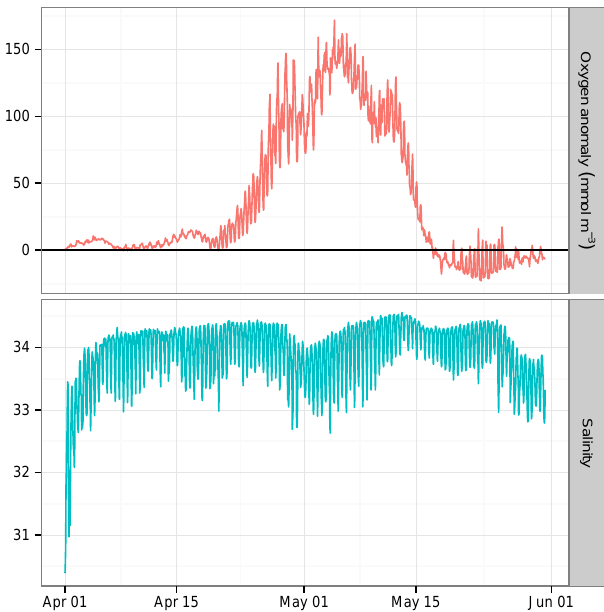
Figure 10. Raw (30min) Warp SmartBuoy time series showing significant variability in oxygen anomaly (red) and salinity (blue) within each tidal cycle. Here the oxygen anomaly neglects the su- persaturating effects of